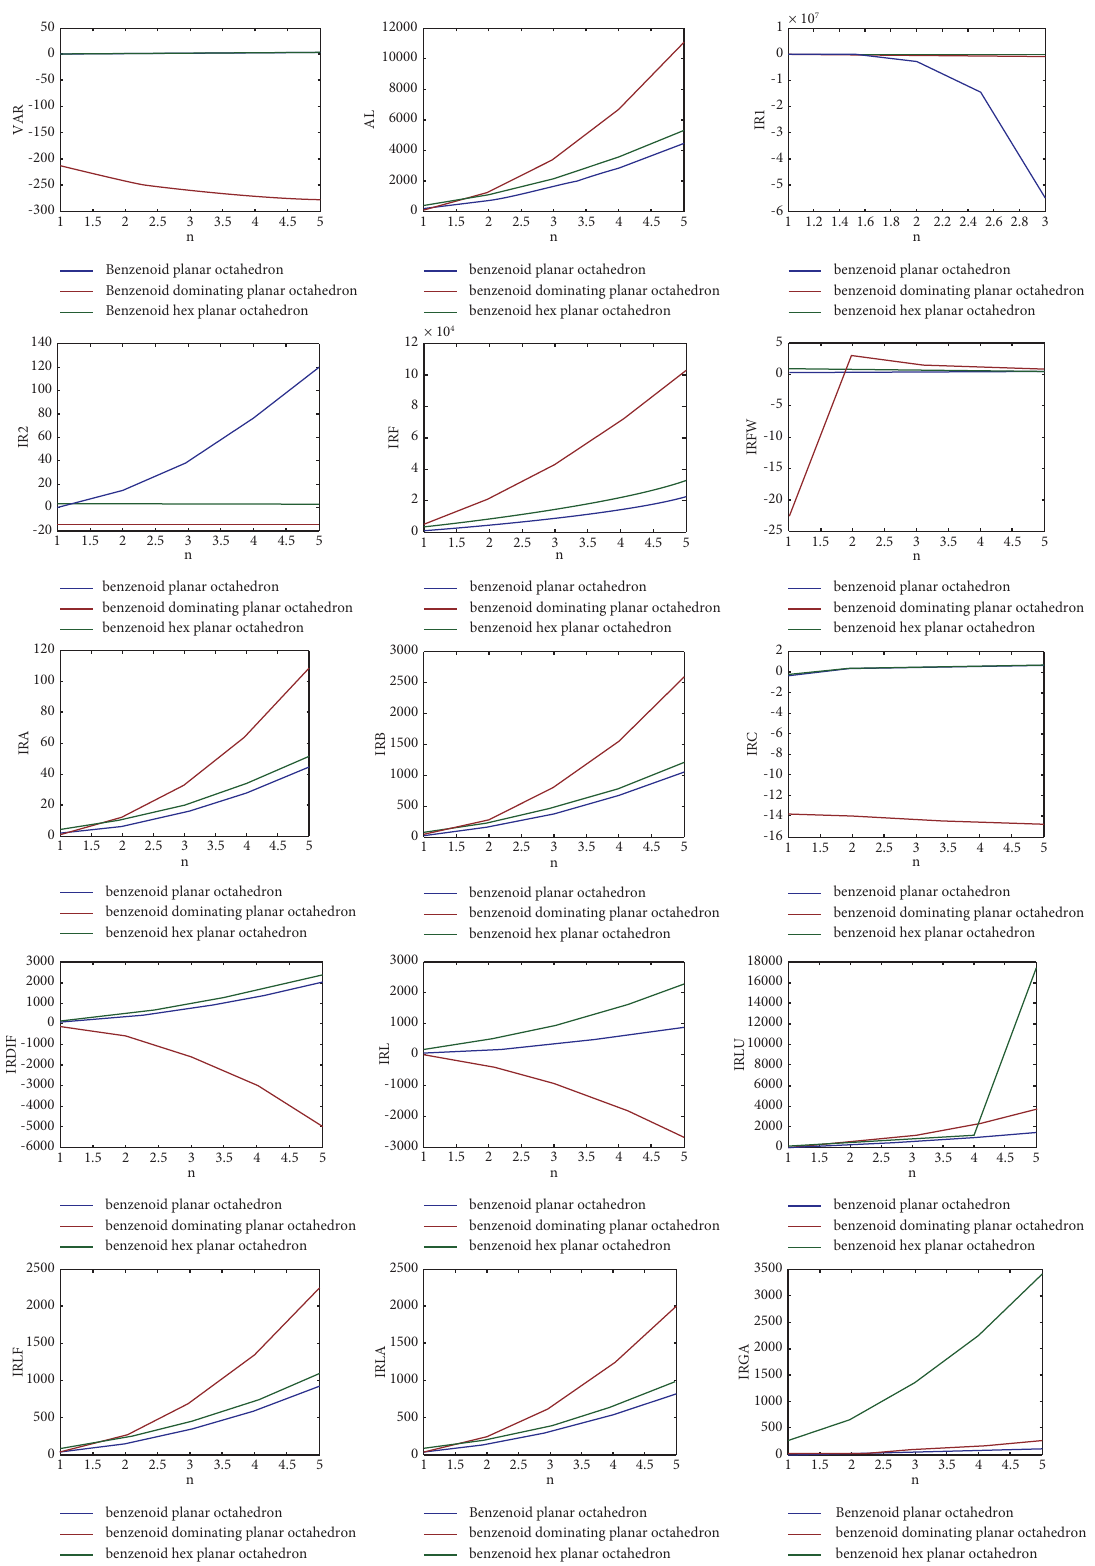
Figure 4: 2D plot for irregularity indices of benzenoid planar octahedron structure, benzenoid dominating planar octahedron structure, and benzenoid hex planar octahedron